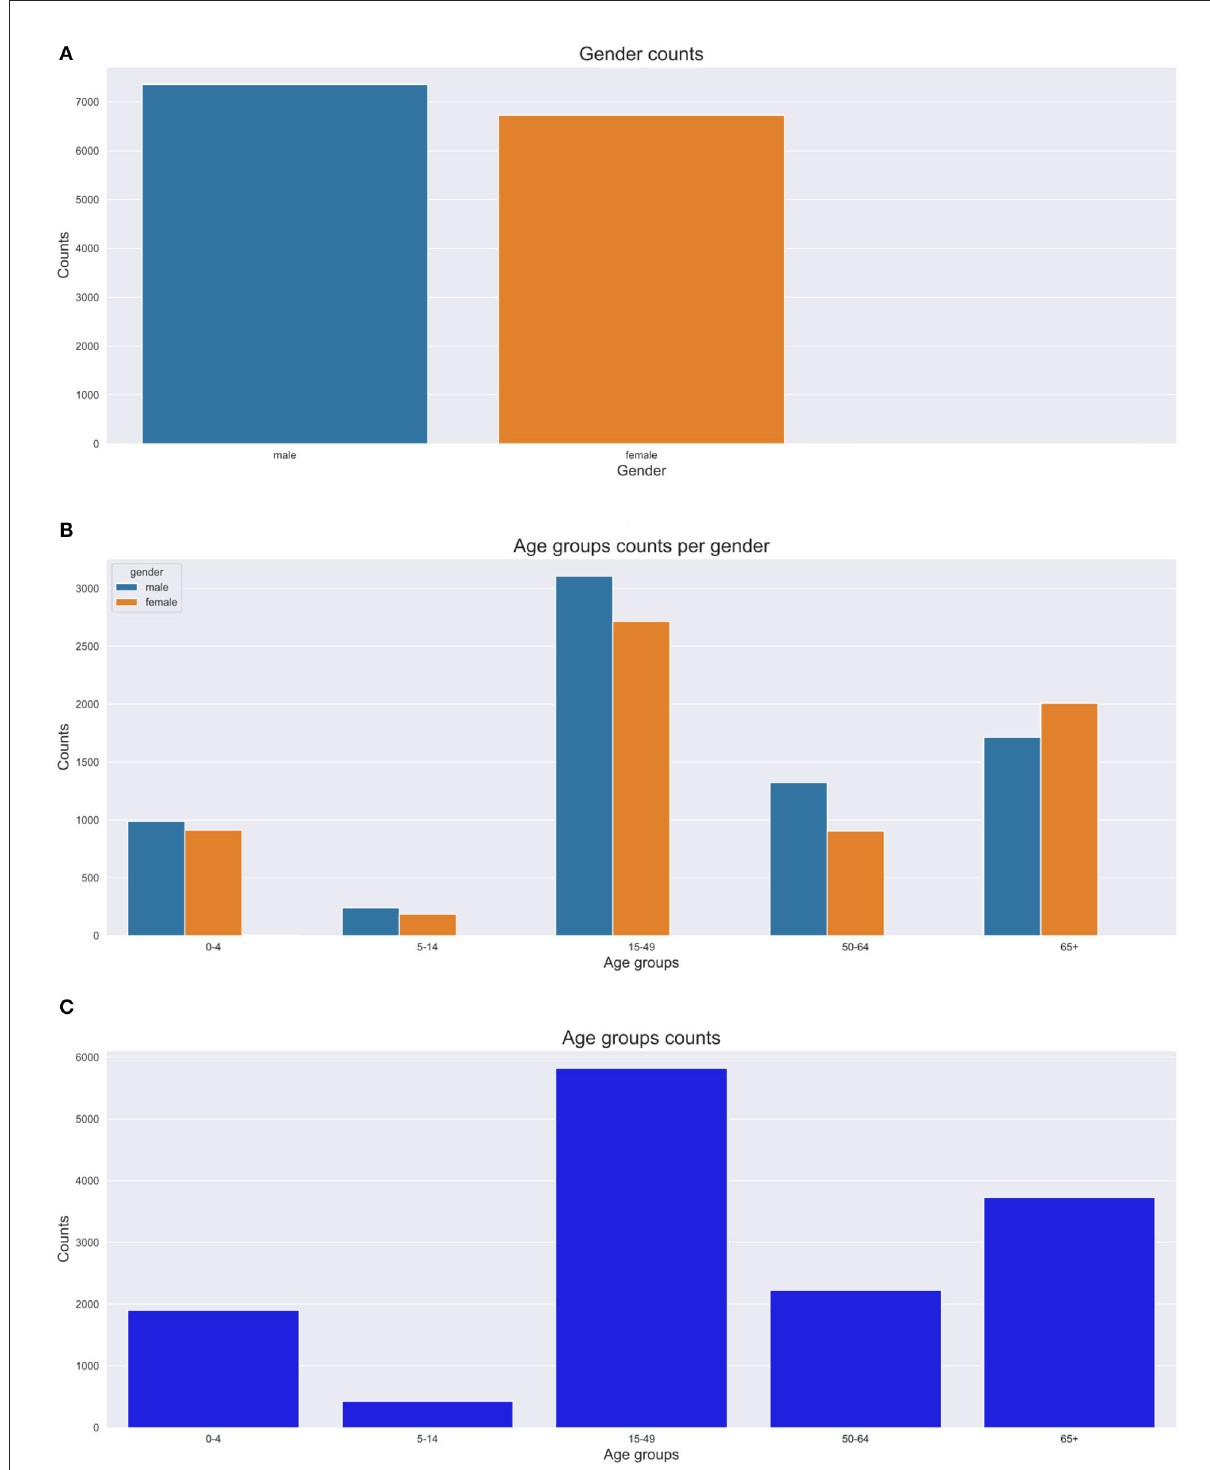
FIGURE5 Gender and age group counts graphs. (A) Gender count. (B) Age group count per gender. (C) Age group